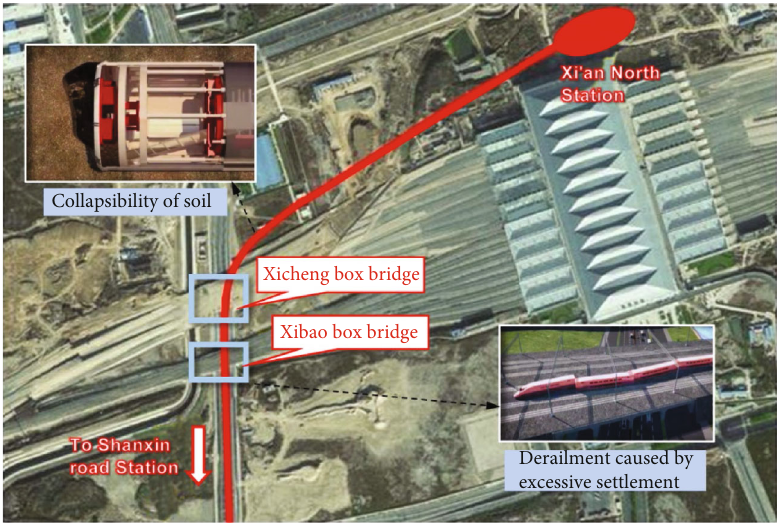
Figure 1: The relationship for the location of Metro Line 4 passing through two box